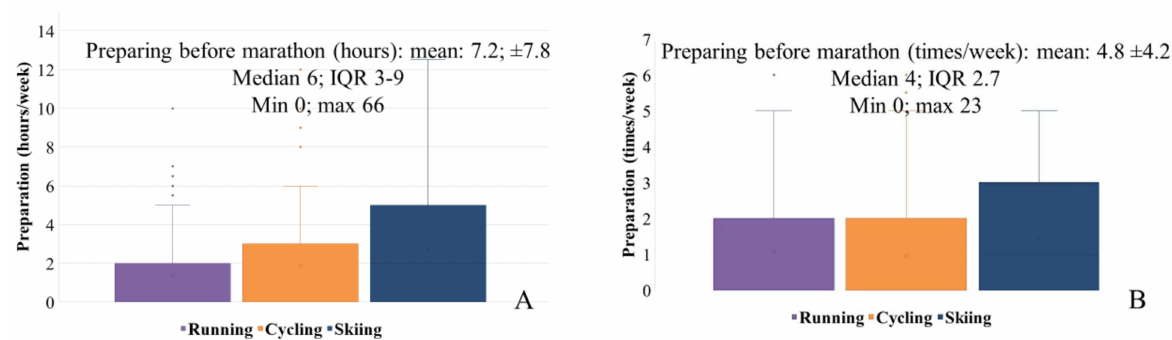
Figure 2. Three mean activities during the 3-month preparation for the marathon (hours ( A ) and times ( B ) are presented for preparing for marathon-independent activities, fitness studios, gymnasium, swimming, and garden tools are